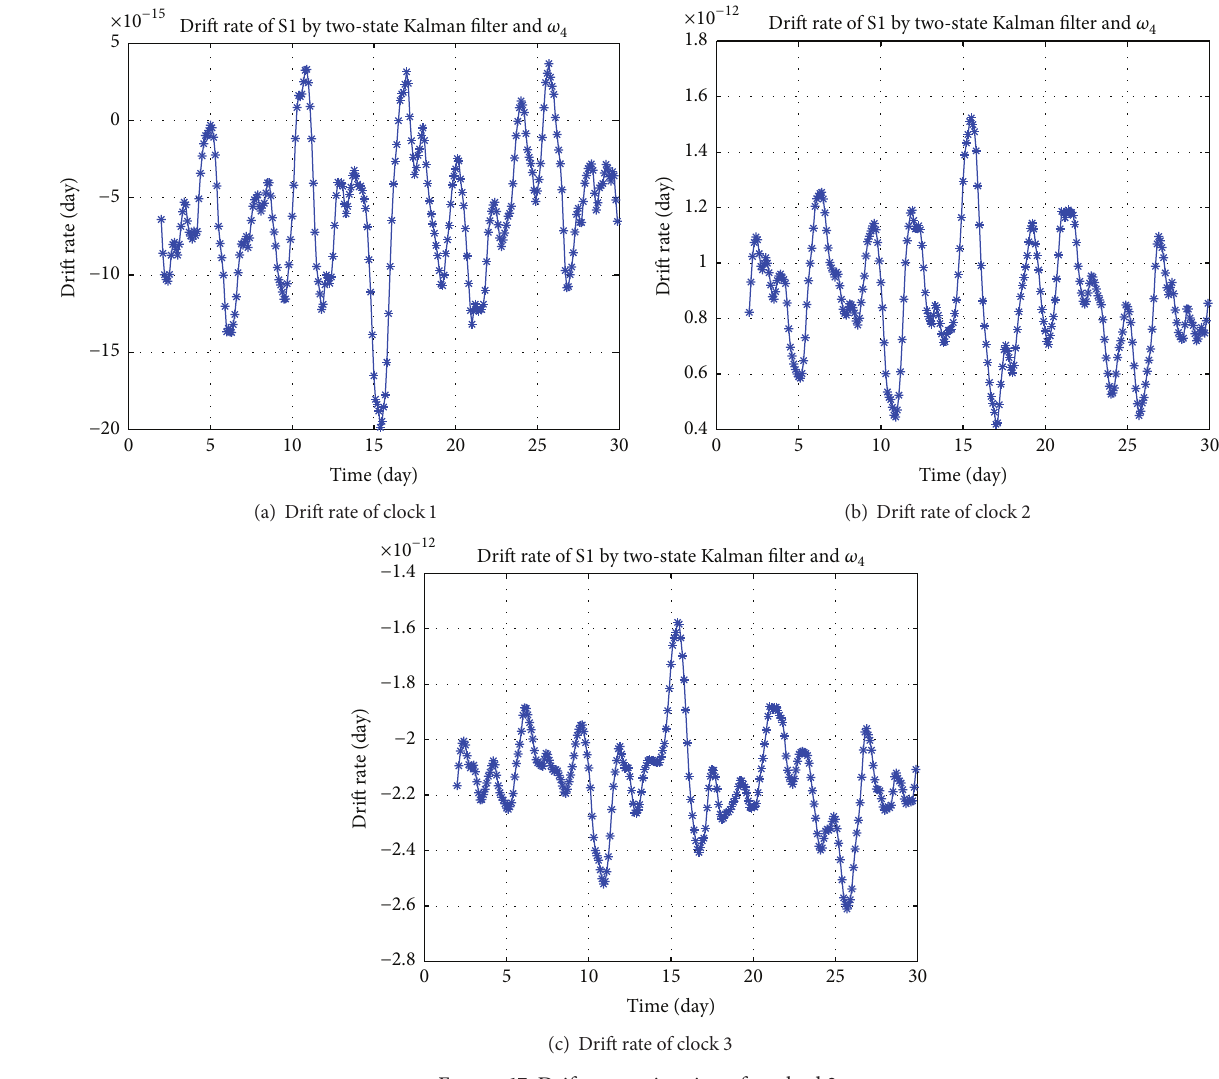
Figure 17: Drift-rate estimation of method